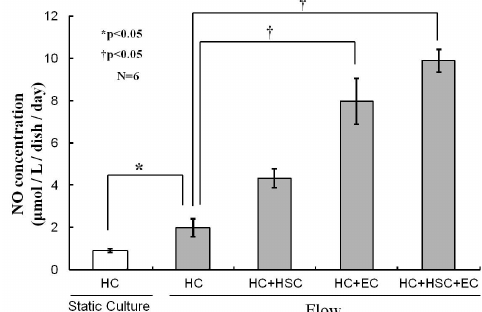
Fig. 6 NO concentration under flow load. NO concentration was measured as in Figure 5. Under flow load, the HC+HSC+EC and HC+EC models exhibited higher NO concentrations than other models containing no EC. Data are presented as the means ± SD. *p<0.05 versus HC model in static culture; †p < 0.05 versus HC model under flow load.